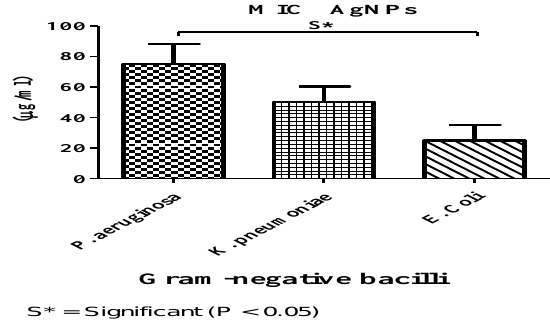
Figure 4. Antibacterial activity of AgNPs against Gram- negative